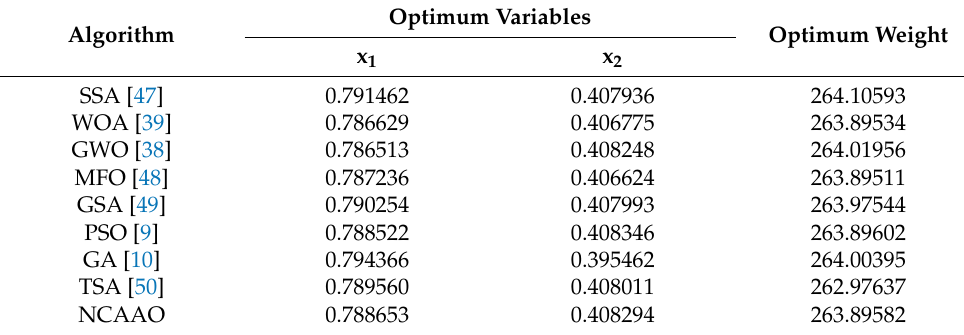
Table 11. Comparison of results for tree-bar truss design